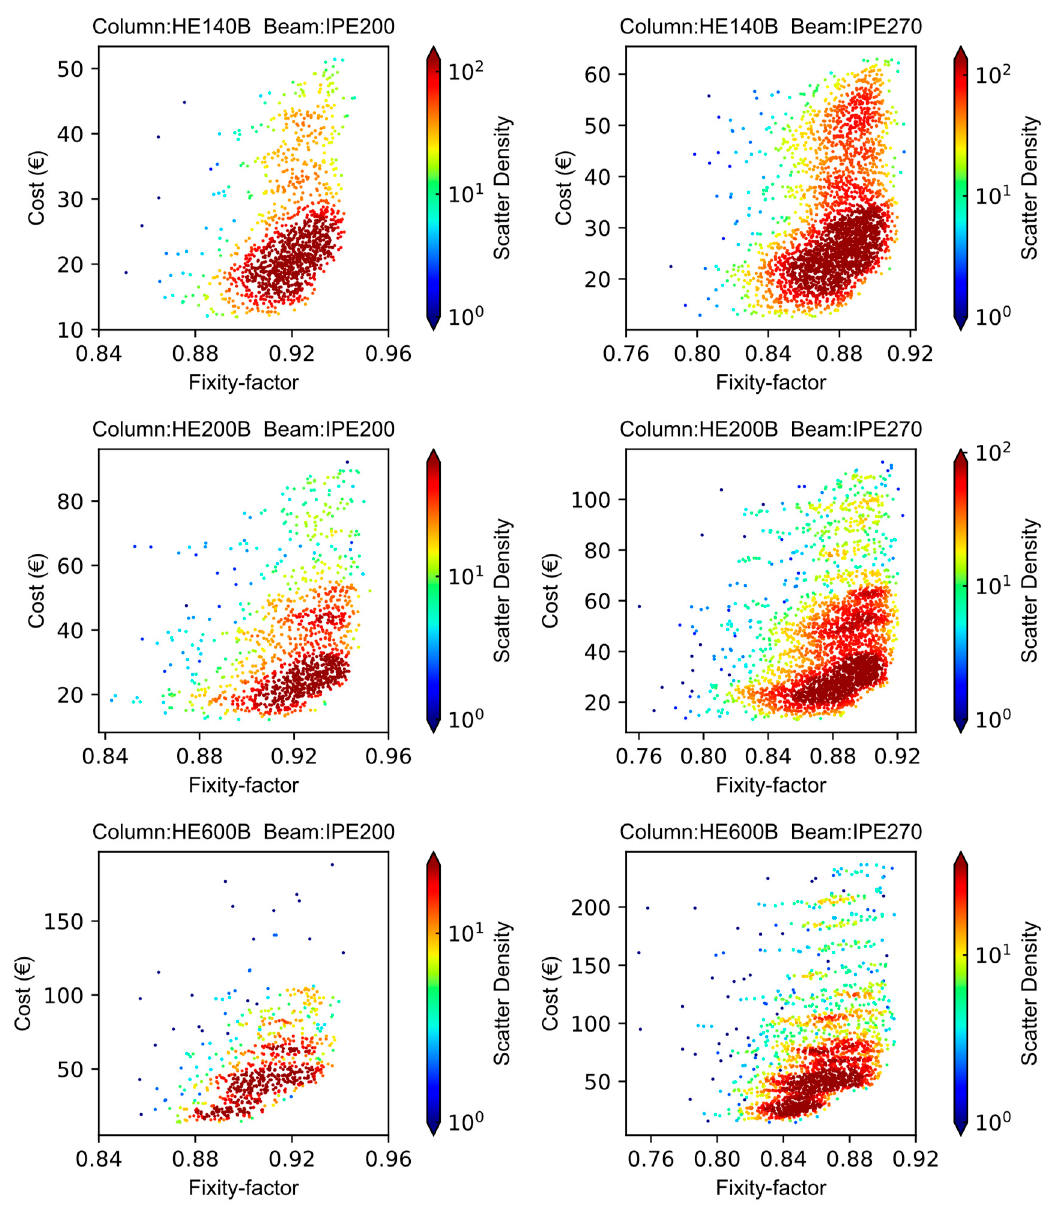
Figure 10. Scatter density diagrams of fixity-factor vs. cost for beam–column in Table 3, with 6 m length of beam.